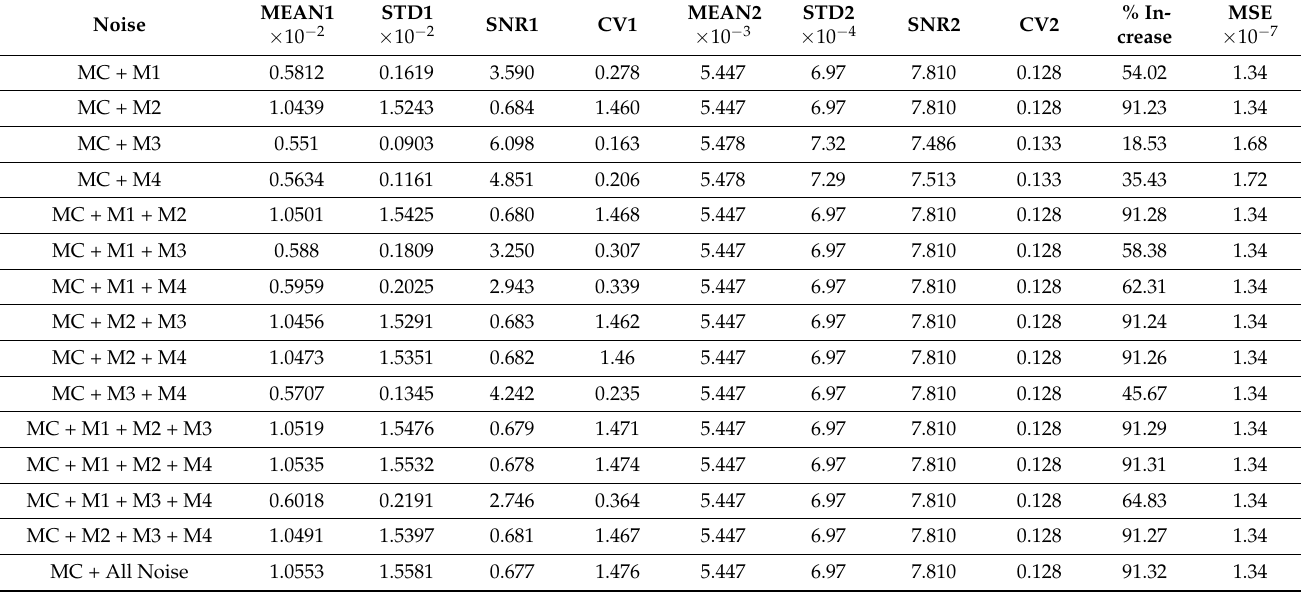
Table 6. Results for real